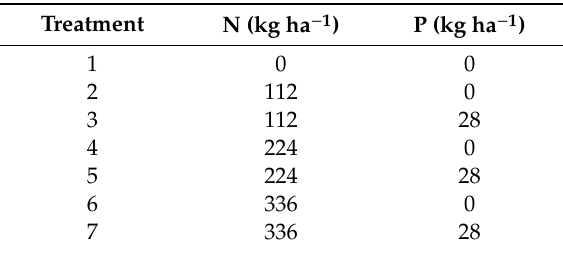
Table 1. RW13 fertilization treatments.